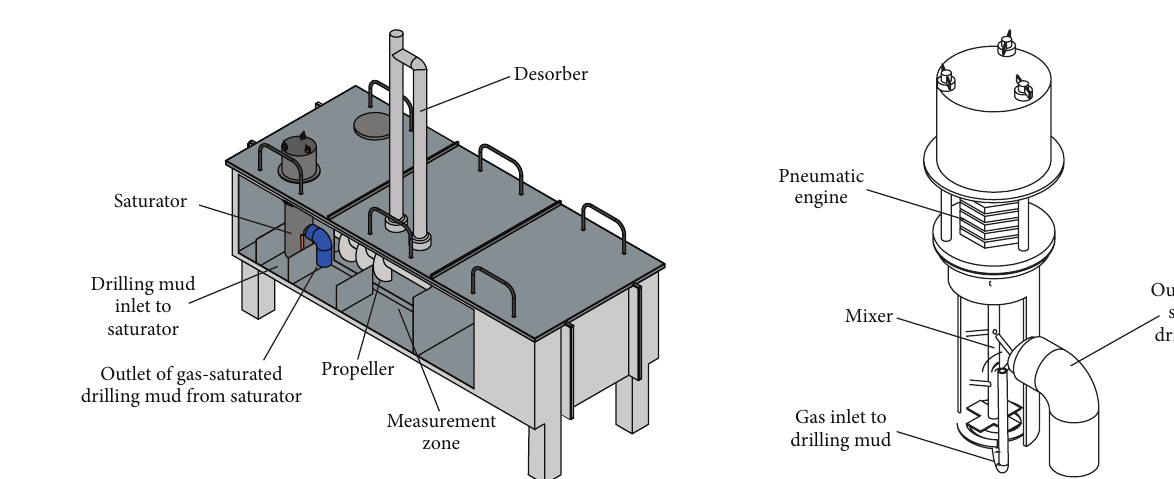
Figure 3: The scheme showing the main parts of the experimental system.